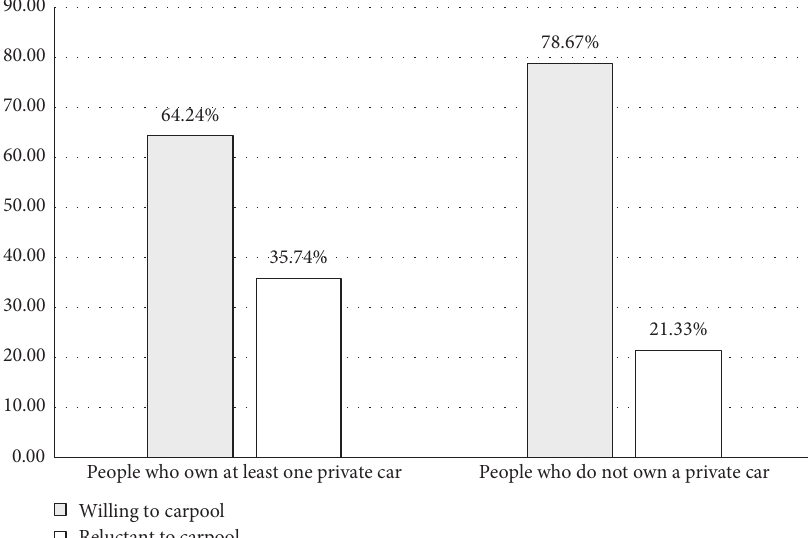
Figure 1: Bar graph of the carpooling willingness.